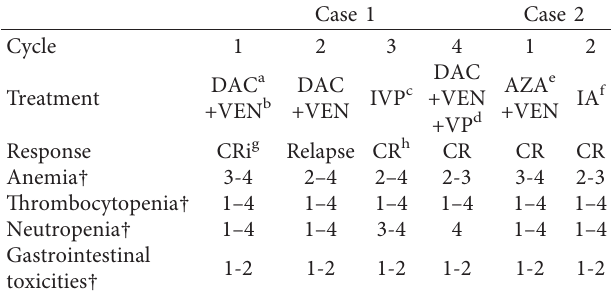
Table 1: Summary of treatment response and related